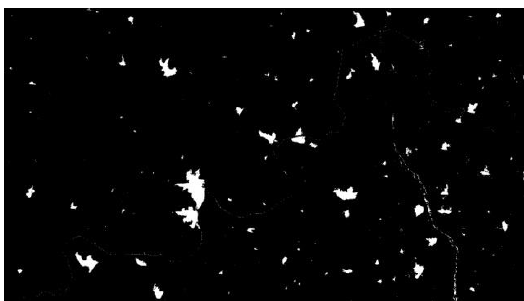
Figure 11: MNDWI Nagarjuna sagar left canal branch